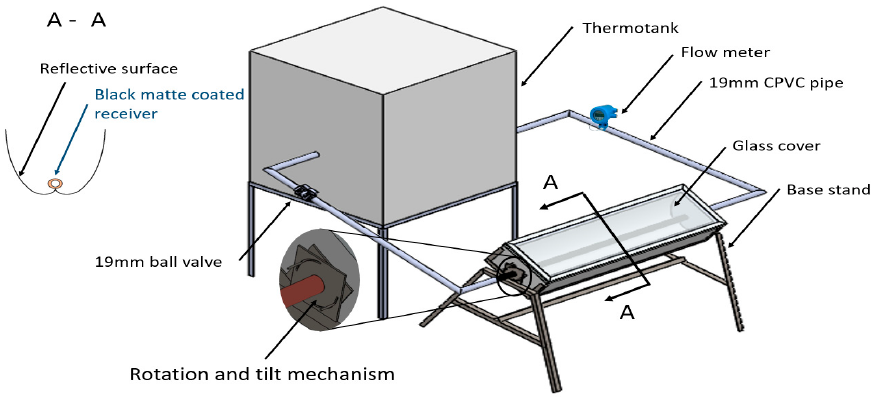
Figure 5. CPC prototype for the present study.